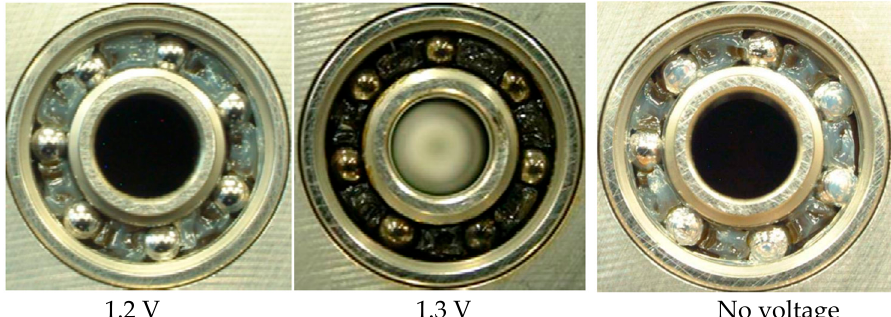
Figure 7. Changes in bearing grease after 500 h of operation at different voltages